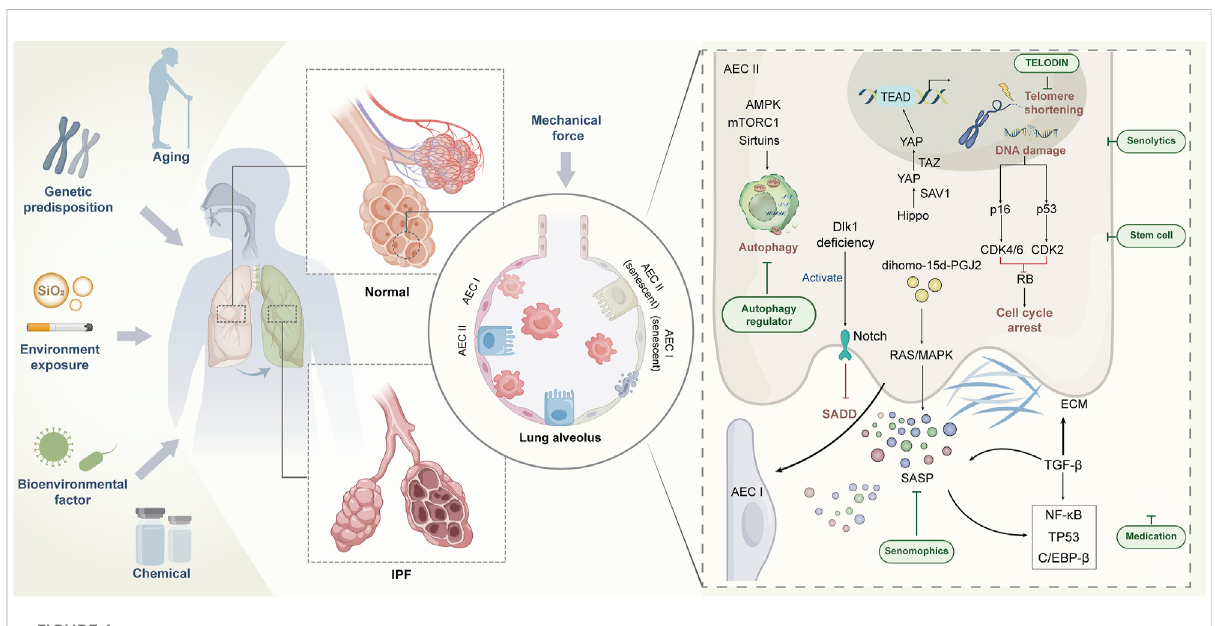
FIGURE 1 Regulation of AECII senescence and strategy of targeting senescent AEC Ⅱ for IPF